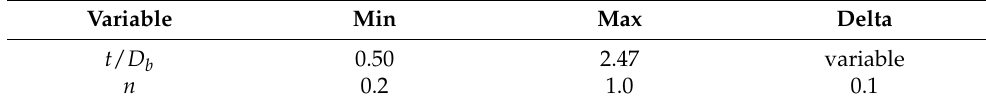
Table 3. The ranges of variation for t / D b and n for Data Sets 2 to 4.